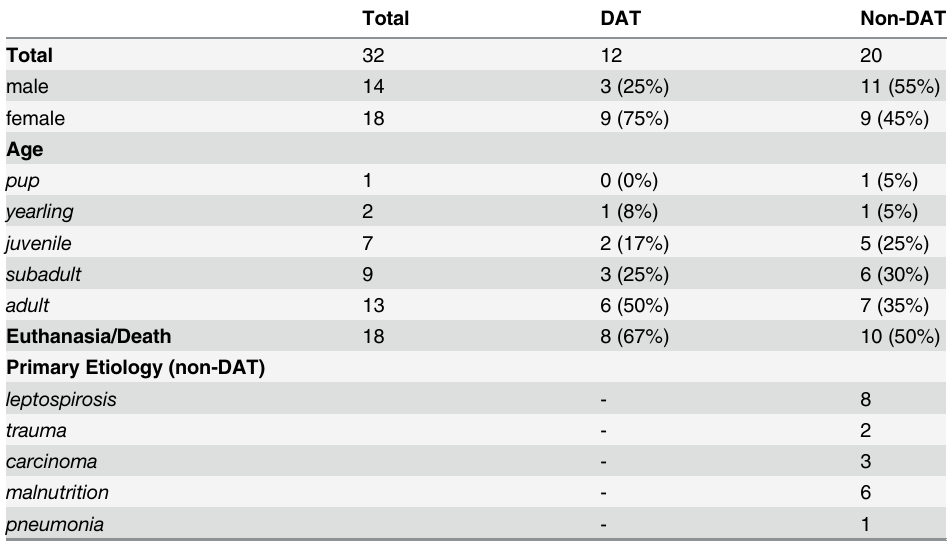
Table 1. Training set characteristics